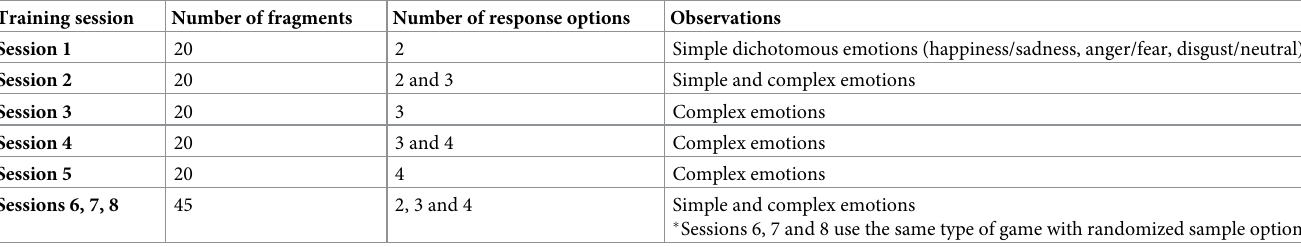
Table 1. Characteristics of the training